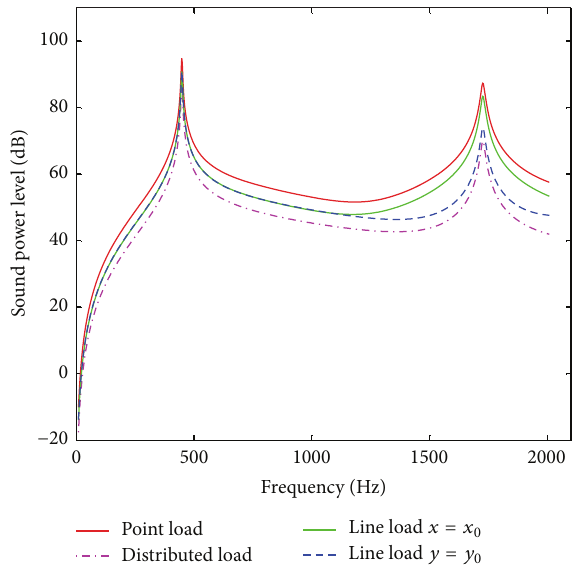
Figure 14: The effect of load type on sound radiation of FGM